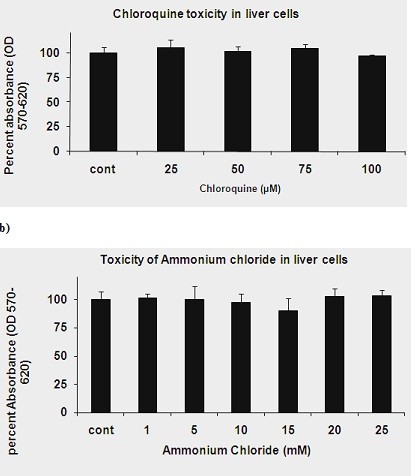
Toxicological study of Chloroquine and NH4Cl in Huh-7 cells: Huh-7 cells were plated at the density of 2 × 104 in 96 well plates. After 24 h cells were treated with different concentrations of chloroquine and NH4Cl and control consisted of solvent in which compound dissolved. After 24 h incubation period add MTT solution to all wells and incubated for 3-4 h at 37°C. Viable cells convert MTT to purple formazan crystal. Added DMSO to dissolve the formazan crystals and read absorbance at 570 nm and 620 nm. (a) Toxicological analysis of Chloroquine in Huh-7 cells through MTT cell proliferation assay. (b) Toxicological analysis of NH4Cl in Huh-7 cells through MTT cell proliferation assay.